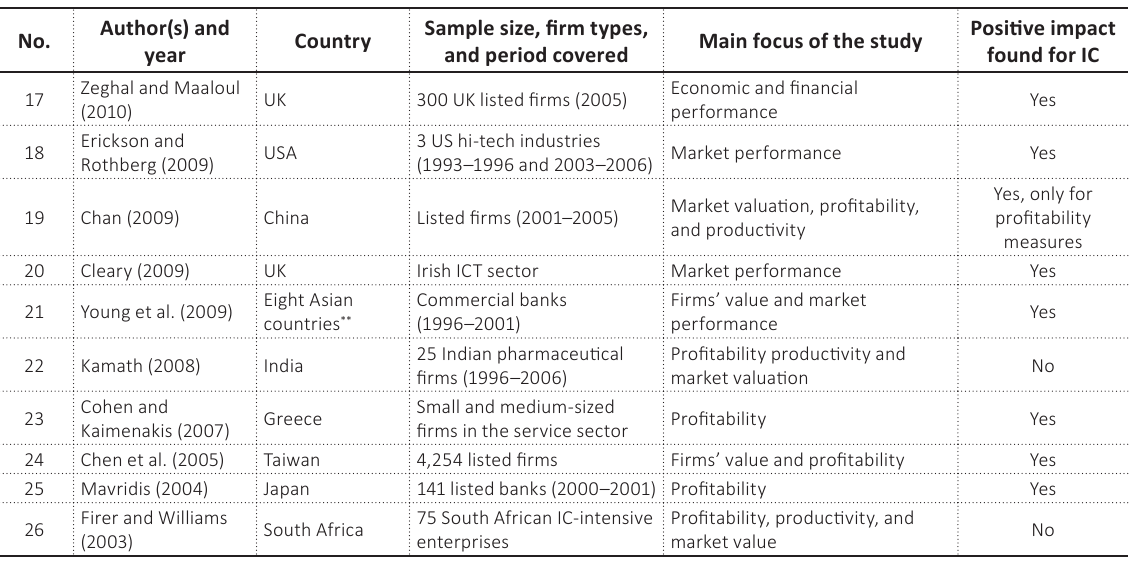
Table 1 (cont.). Studies on the association between IC and